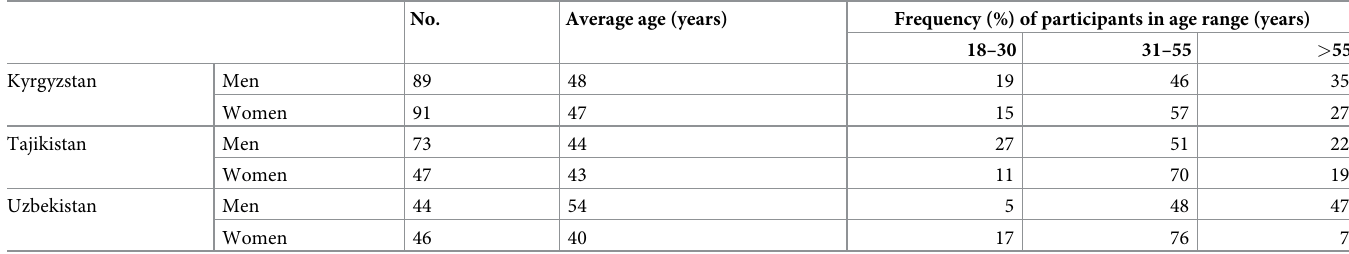
Table 1. Characteristics of study